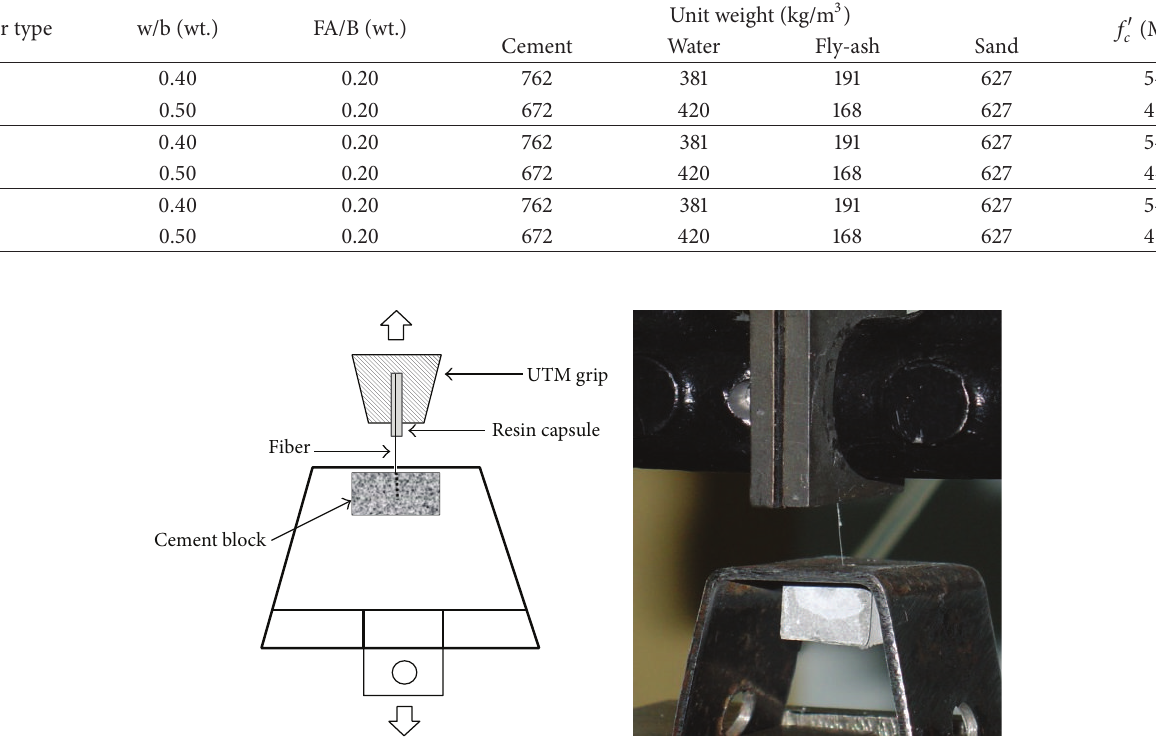
Figure 3: Schematic drawing for single-fiber pull-out test and photograph of test set-up.